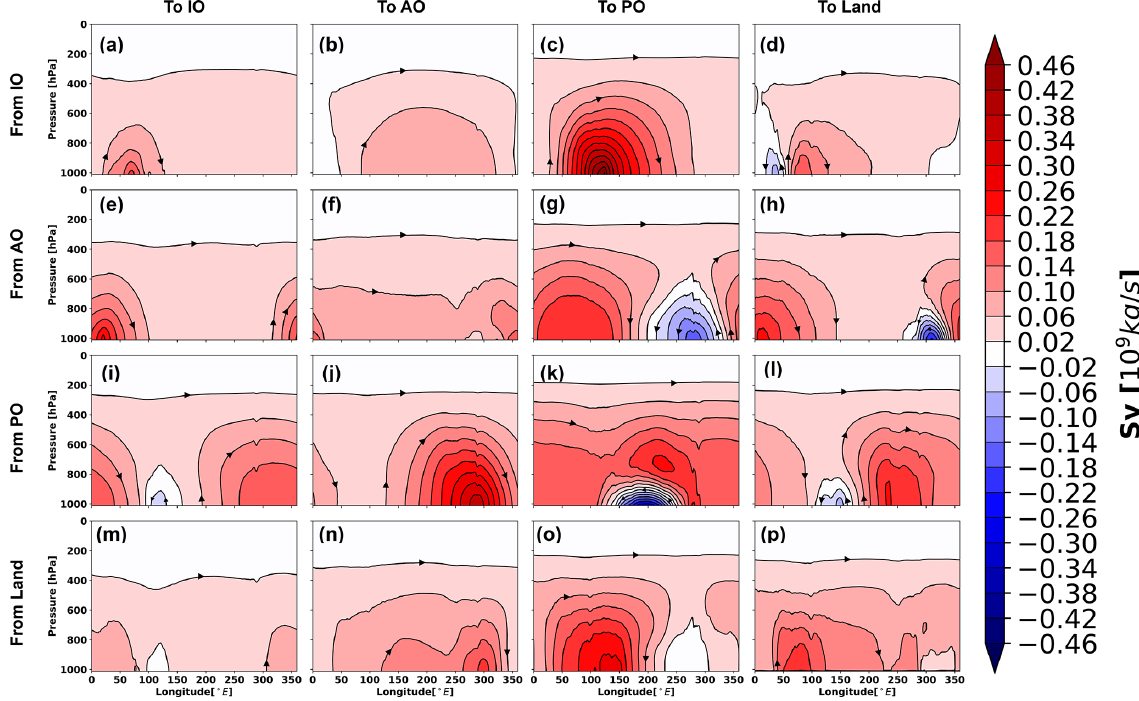
Figure 4. Same as Fig. 3, but for the zonal overturning stream function.